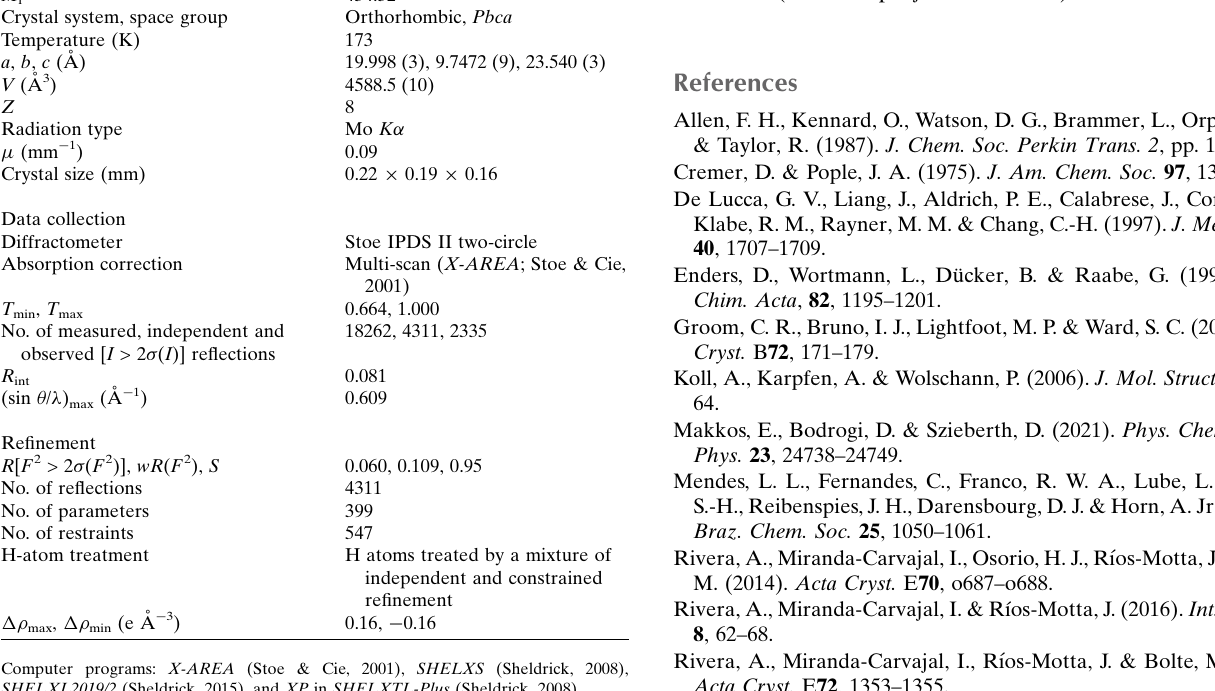
Table 2 Experimental details. Crystal data Chemical